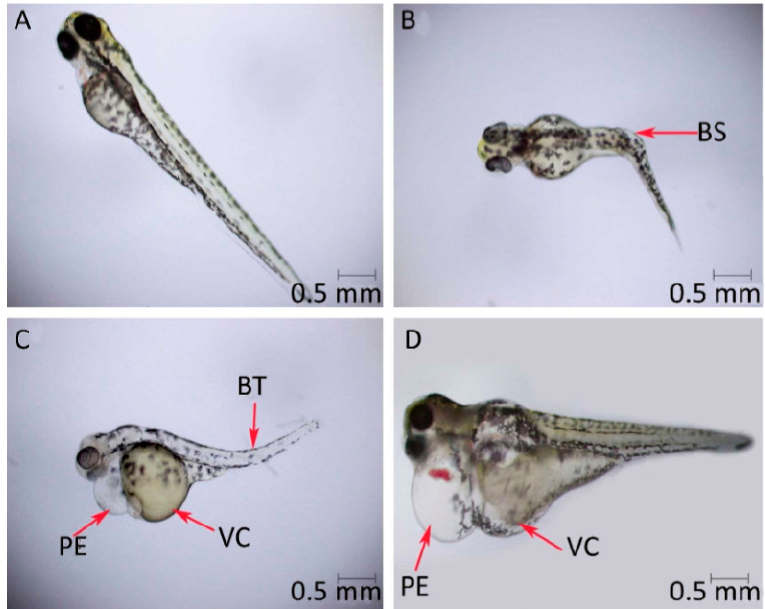
Figure 12. Deformity of zebrafish embryos when exposed to graphene quantum dots of concentration 200 μ g/mL, scale bar = 0.5 mm. ( A ) Standard larvae and ( B – D ) abnormal larvae. Deformities are specified by red arrows. BT, bent tail; BS, bent spine; VC, vitelline cyst; and PE, pericardial edema. Reproduced from reference [185], with permission from Elsevier, 2015.